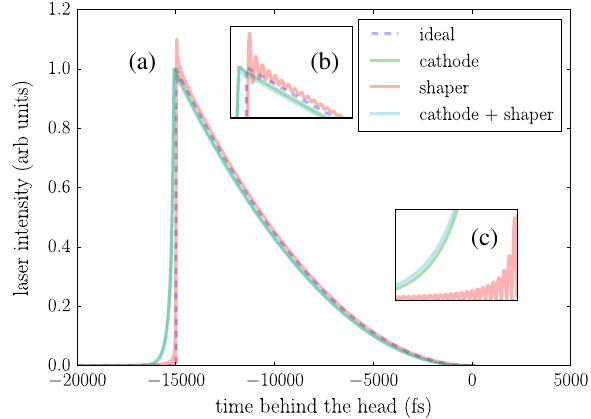
FIG. 6. Comparison of nominal ( “ ideal ” ) quadratic shape with the shapes achieved when taking into account the photoemission response time ( “ cathode ” ), the laser-pulse-shaping finite band- width ( “ shaping ” ), and both effects ( “ cathode þ shaper ” ). The ideal laser temporal profile is described by Eq. (19) with α ¼ 2 and τ ¼ 15 ps. Insets (b) and (c) are zooms of the areas t ∈ ½ − 15200 ; − 13600 (cid:2) fs (peak location) and t ∈ ½ − 16000 ; − 15020 (cid:2) fs (left edge of the profile), respectively. The head of the laser pulse is at t ¼ 0 .